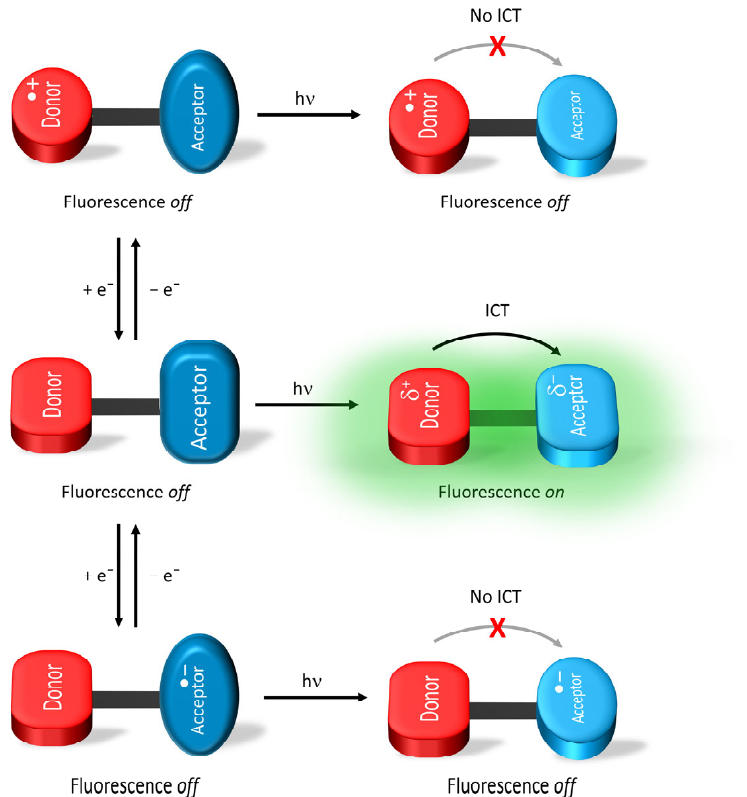
Figure 3. Electrofluorochromic mode of action of photoemission modulation by twisted intramolecular charge transfer.